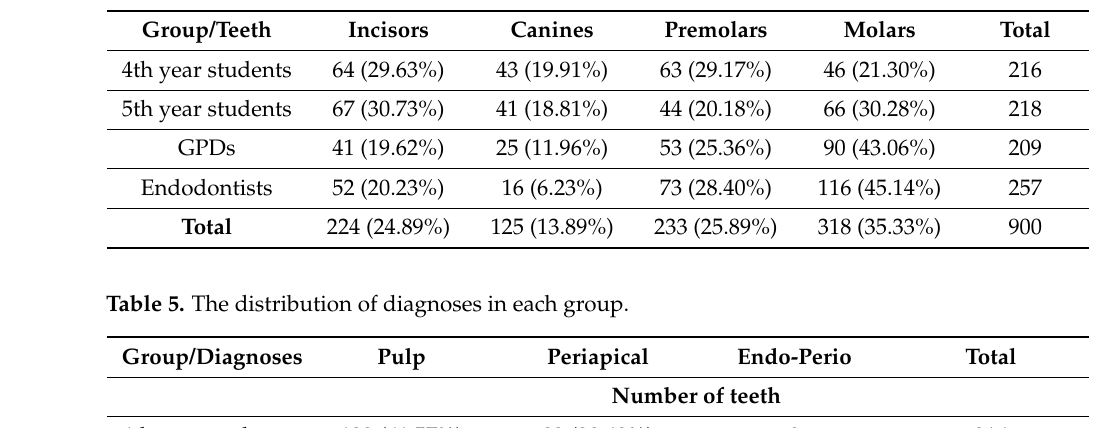
Table 4. The distribution of teeth in each group.